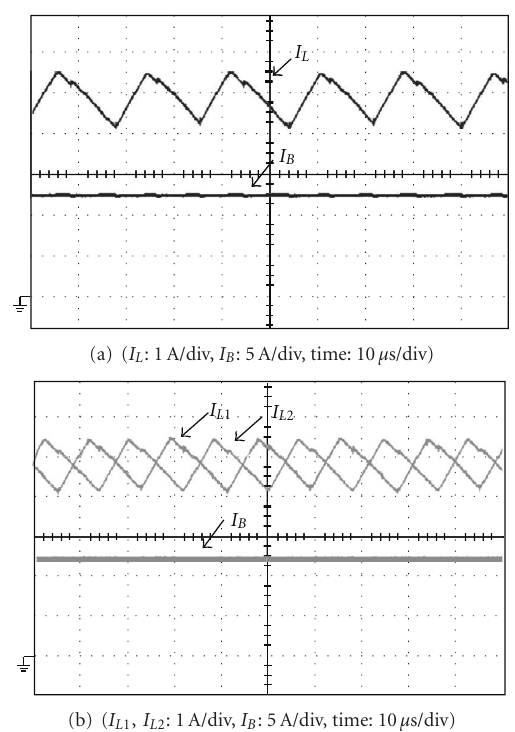
Figure 17: Measured waveforms of inductor current I L and charging current I B of (a) single boost converter and (b) the proposed interleaving boost